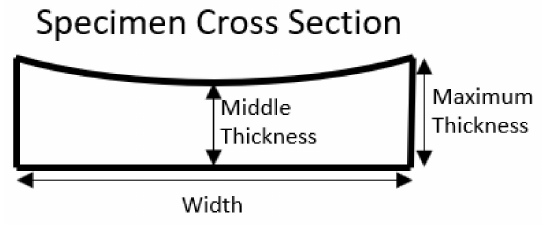
Figure 15. Resulting tow cross-section schematic.